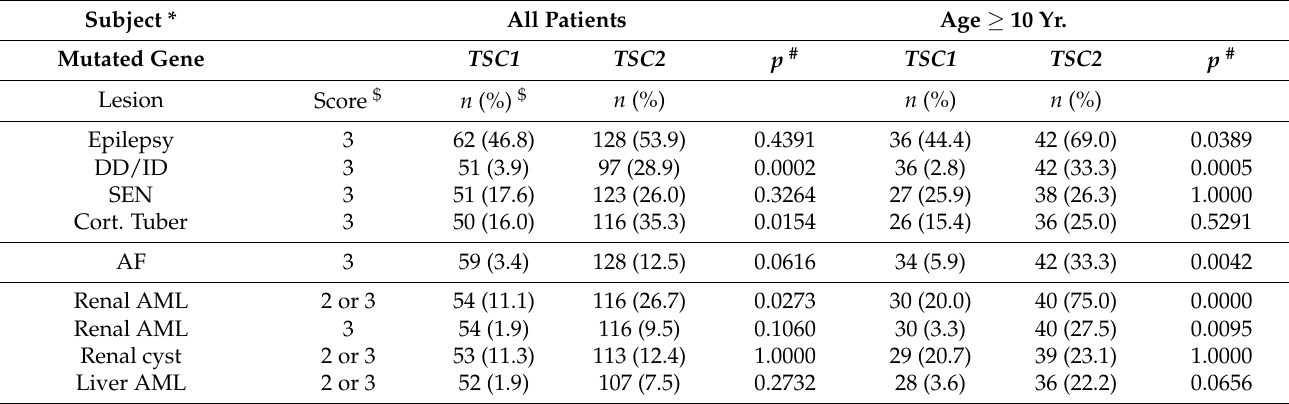
Table 7. Proportion of severe lesions between TSC1 and TSC2